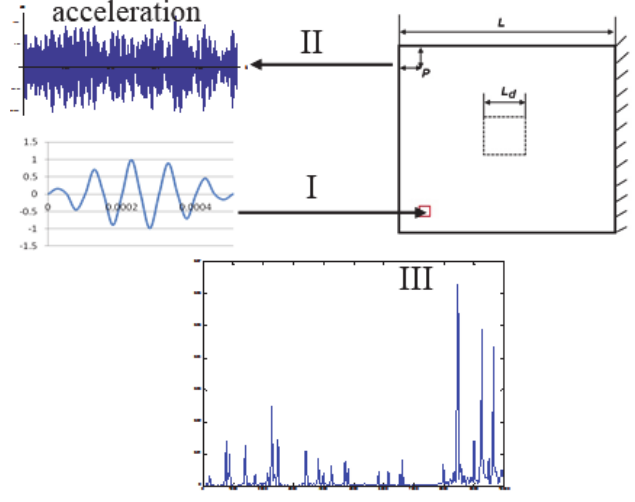
Figure 6: Algorithm of transient analysis